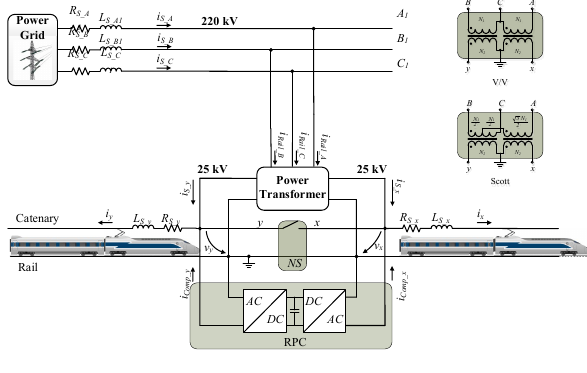
Figure 9. Electrical schematic of the RPC connection with the railway power system powered by V/V or Scott